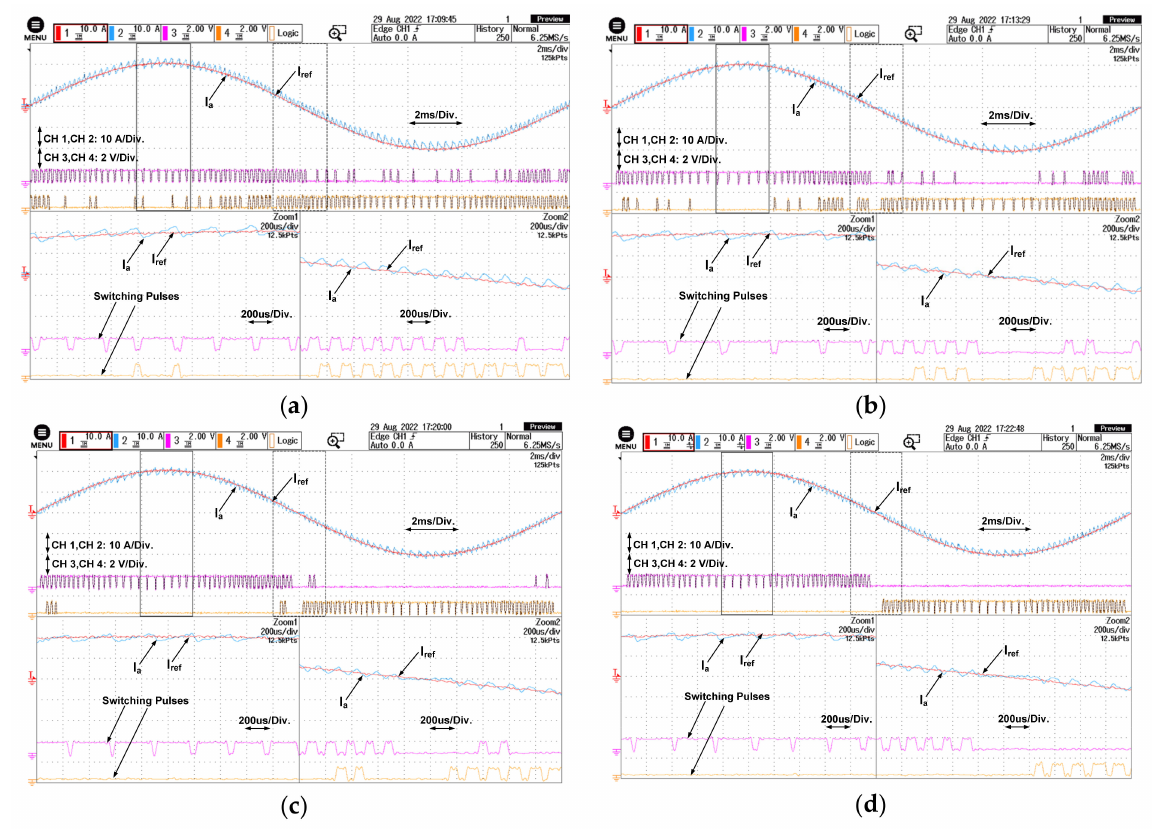
Figure 14. Experimental results showing I ref , I a , and switching pulses for ( a ) PSO-OFHCC, ( b ) FBI-OFHCC, ( c ) AOA-OFHCC, and ( d ) IAOA-OFHCC.